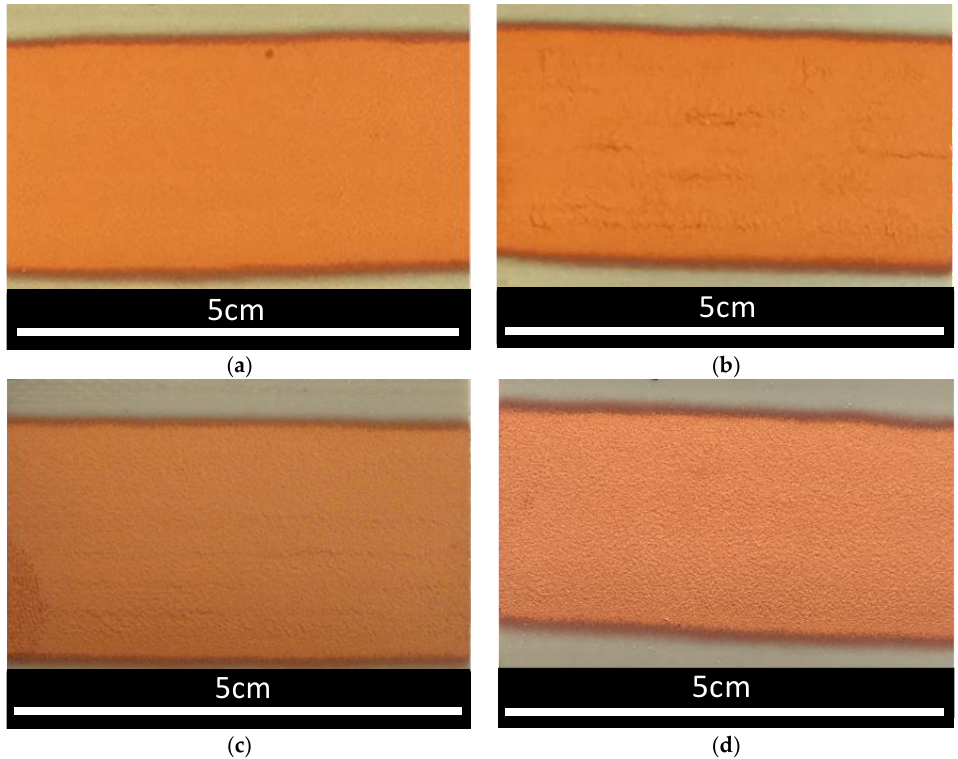
Figure 4. Coating obtained with the deposition set V5 ( a ), V6 ( b ), V7 ( c ), V8 ( d ).